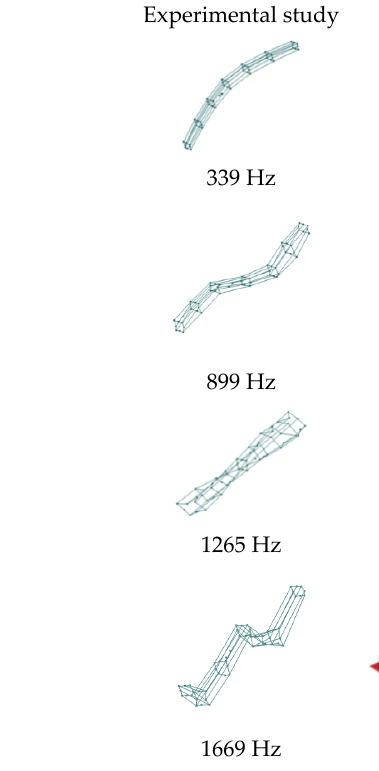
Figure 8. A comparison of selected calculated and experimentally verified mode shapes of the steel–polymer concrete.